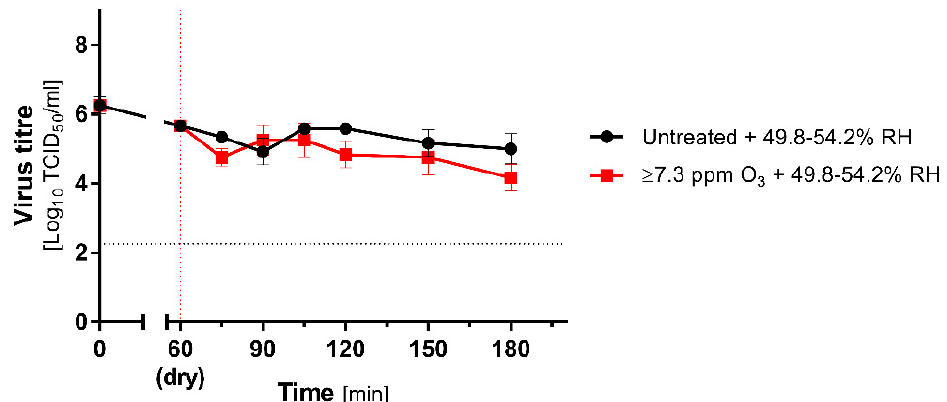
Figure 4. Inactivation of coronavirus during ozone treatment under high RH. Comparison of mean ( ± SD, n = 3) titres of MHV recovered from contaminated carriers subjected to ozone treatment ( ≥ 7.3 ppm, red lines) and untreated (black lines) at 49.8–54.2% RH (high RH). The vertical dotted line represents the end of drying and beginning of O 3 treatment, and the horizontal dotted line represents 4 logs virucidal efficiency threshold with respect to the initial titre.